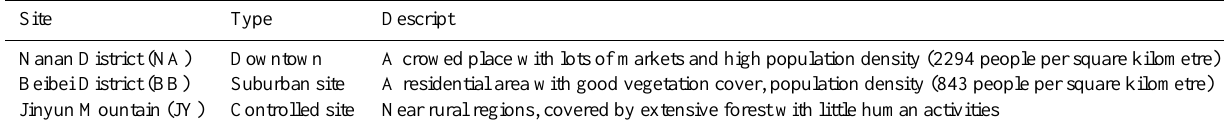
Table 1. Description of sampling sites in core urban areas, Chongqing, China.